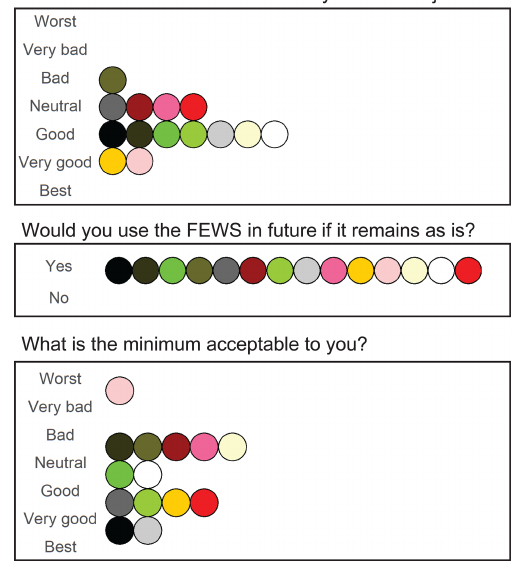
Figure 7. Stakeholder perceived satisfaction with FANFAR FEWS performance in the 2020 rainy season for objective 11. Accuracy . Colored dots represent unique respondents ( N = 12; 63% of 19